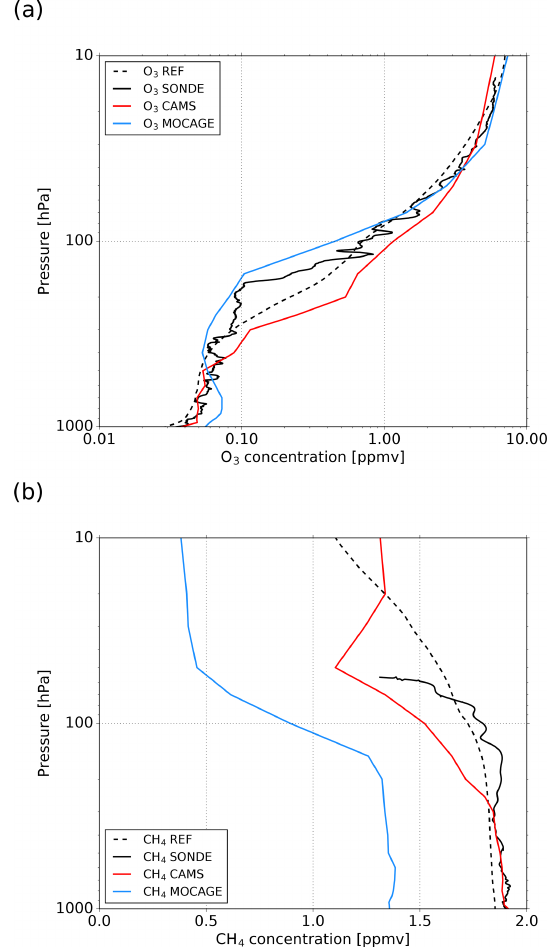
Figure 11. Ozone (a) and methane (b) in situ profiles in black lines compared to O 3 and CH 4 a priori profiles from CAMS in red lines and MOCAGE in blue lines and compared to O 3 and CH 4 reference profiles in dotted lines for in situ sounding from 17 April 2018 at